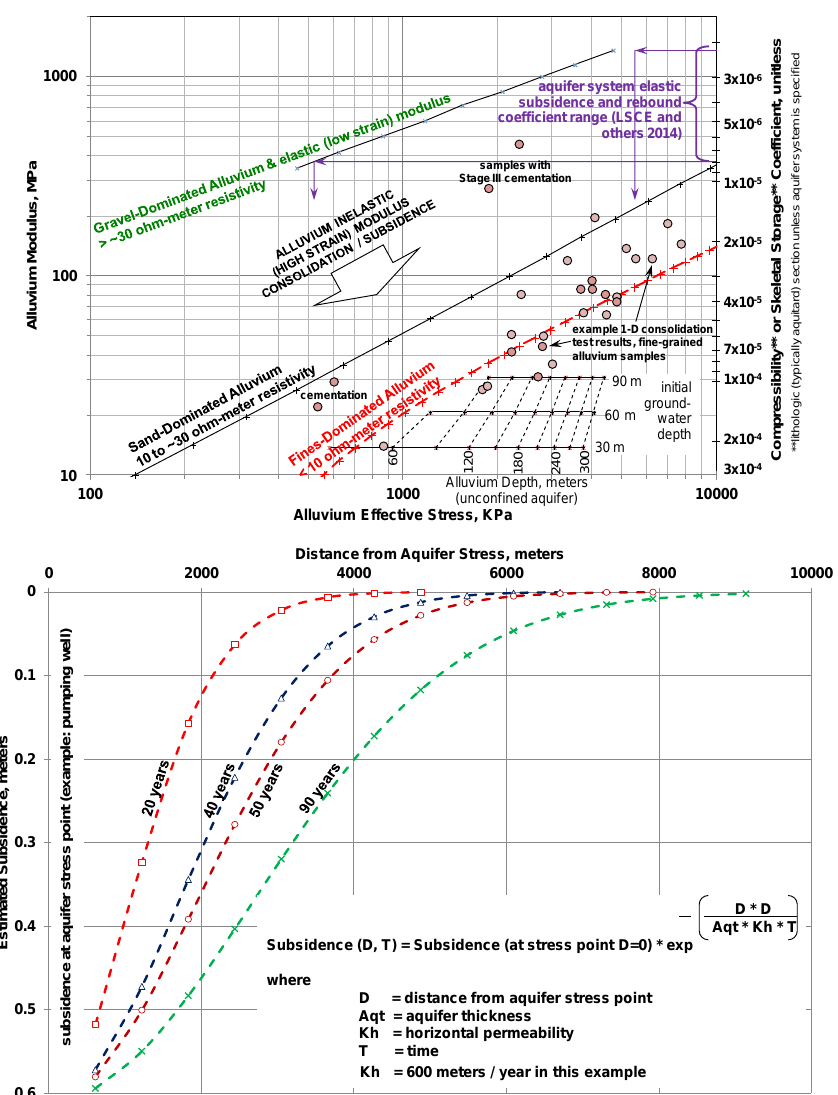
Figure 2. Subsidence modulus parameters are related to compressibility over a range of effective stress in Fig. 2a (top). Example test results are from deep wells in the east Salt River Valley, Arizona. Lateral subsidence propagation over time is shown in Fig. 2b (bottom).